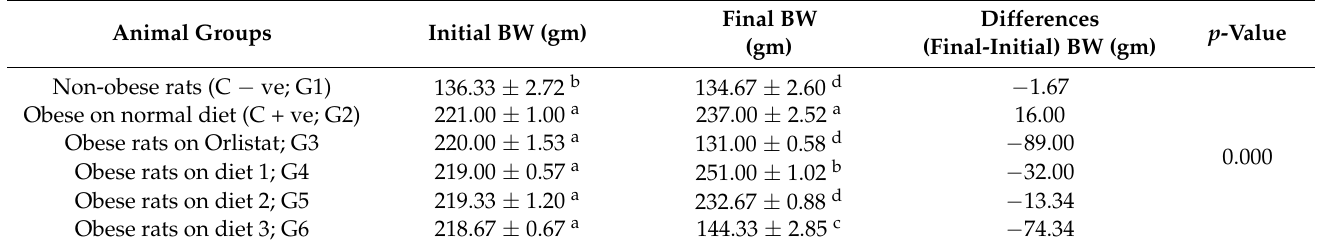
Table 2. Effects of biscuits supplemented with different DF levels on body weight levels of obese